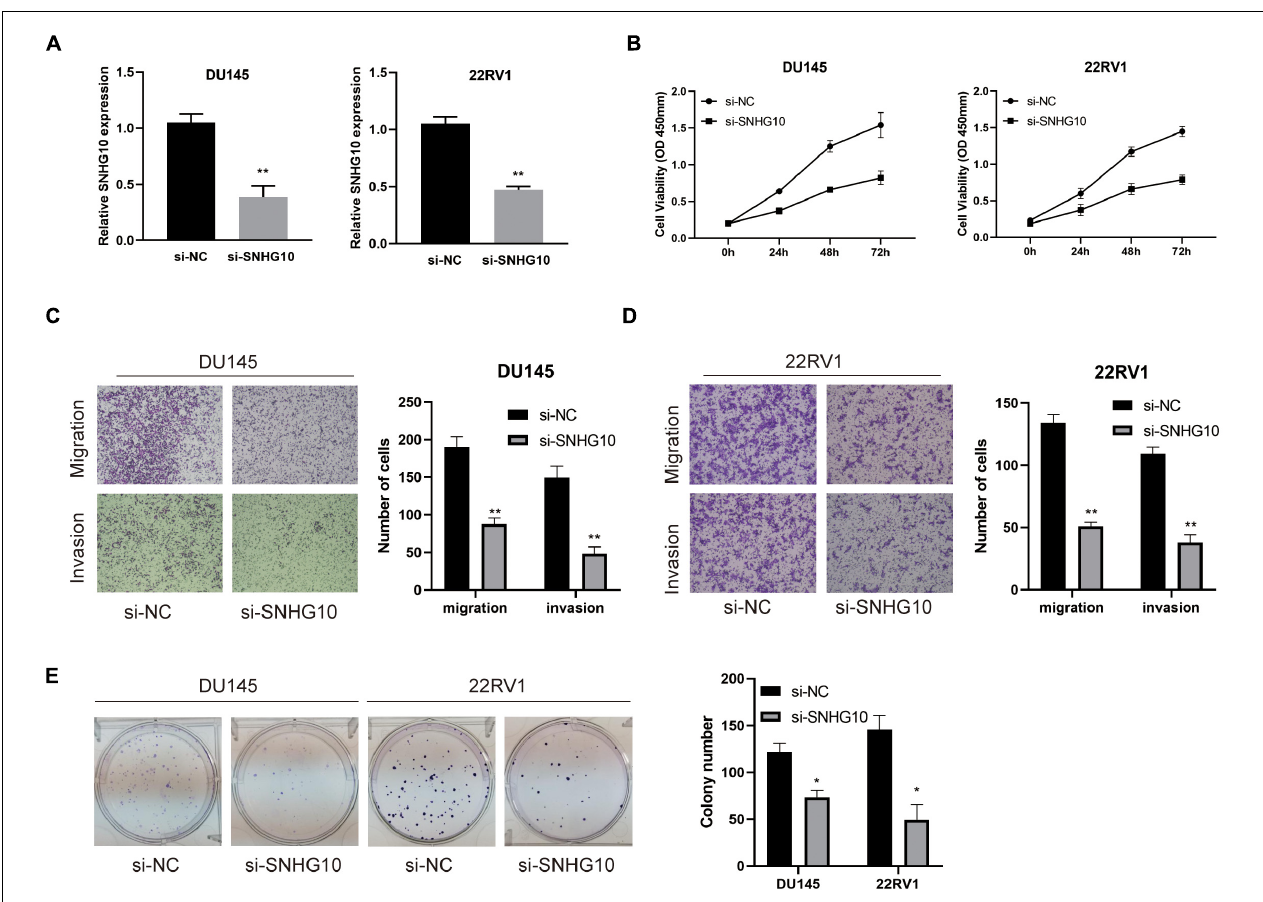
FIGURE 9 | The biological role of SNHG10 on PC cell proliferation, migration, and invasion. (A) SNHG10 expression was verified after transfection in DU145 and 22RV1. (B) CCK8 assay showing attenuated DU145 and 22RV1 cell growth after knocking down SNHG10 expression. (C,D) Migration and invasion abilities of DU145 and 22RV1 were weakened after knocking down SNHG10. (E) Knockdown of SNHG10 inhibited colony formation and cell growth of DU145 and 22RV1. The data represent the mean ± SD from three independent experiments. * P < 0.05 and ** P <